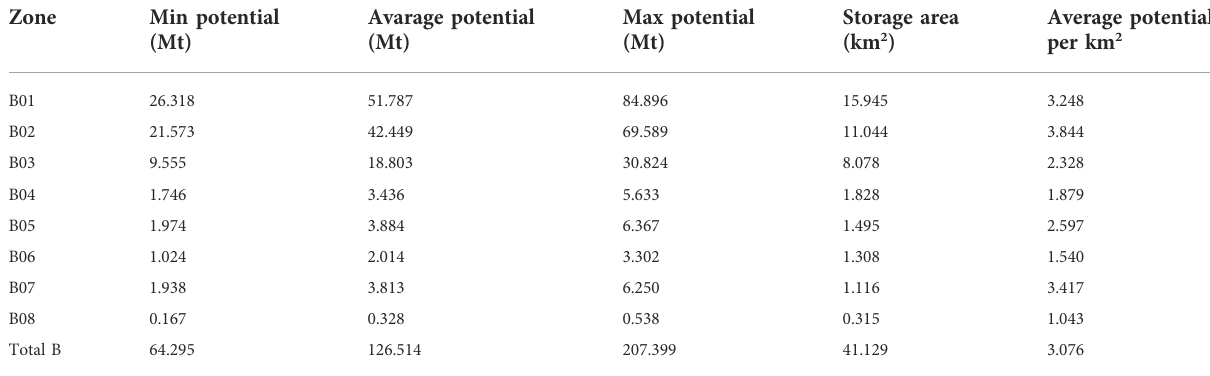
TABLE 5 CO 2 geological storage potential of reservoir B.